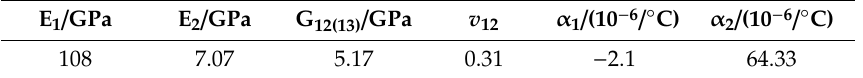
Table 2. Comparison of the average curvatures with analytical models and simulation.